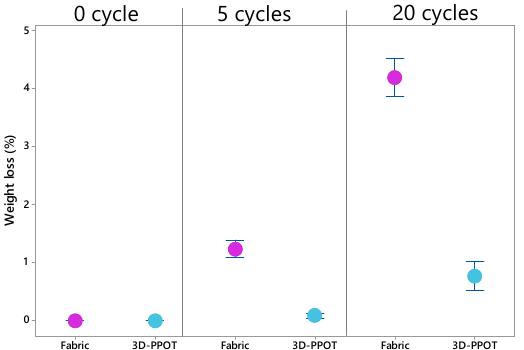
Figure 8. Weight loss (%) of woven fabric and 3D-PPOT material after 0, 5 and 20 cycles.